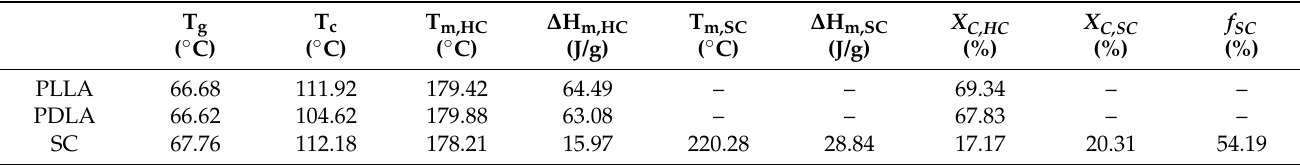
Table 1. Thermal properties of the PLLA, PDLA, and